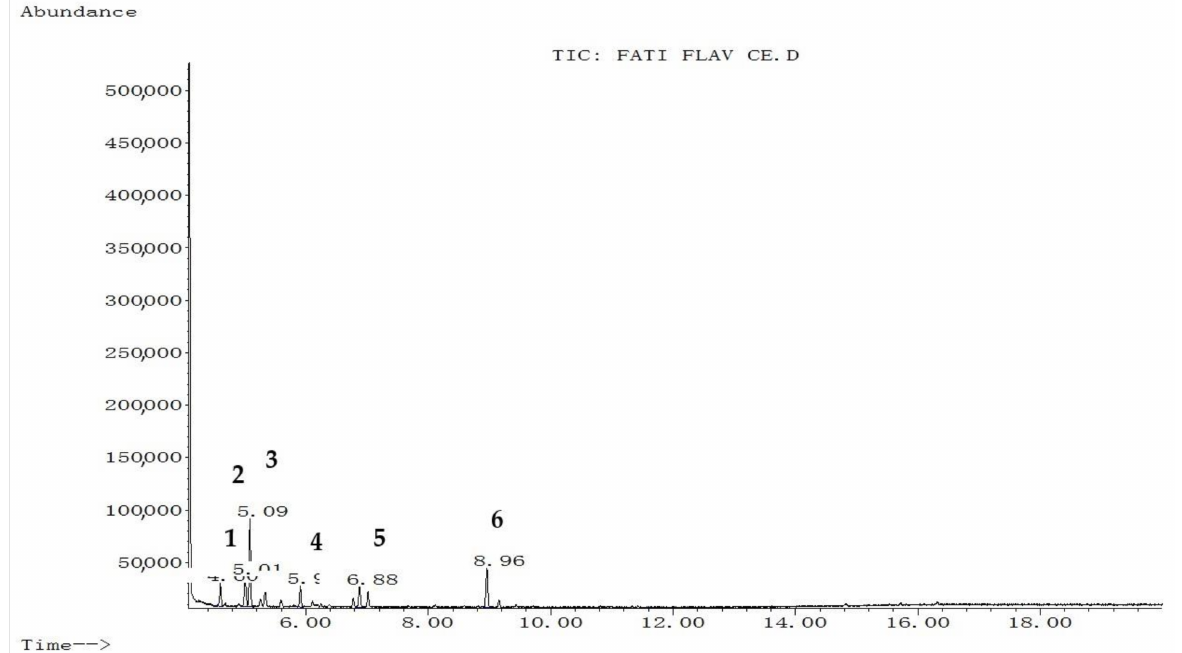
Figure 1. Chromatographic profile of hydroethanol fraction of C. europaea after silylation. 1 : Coumaran-3-one; 2 : 2- Phenylthiophene; 3 : Oxalic acid, 4 : Proline; 5 : Propanoic acid, 2-[(trimethylsilyl)oxy]-, trimethylsilyl ester.